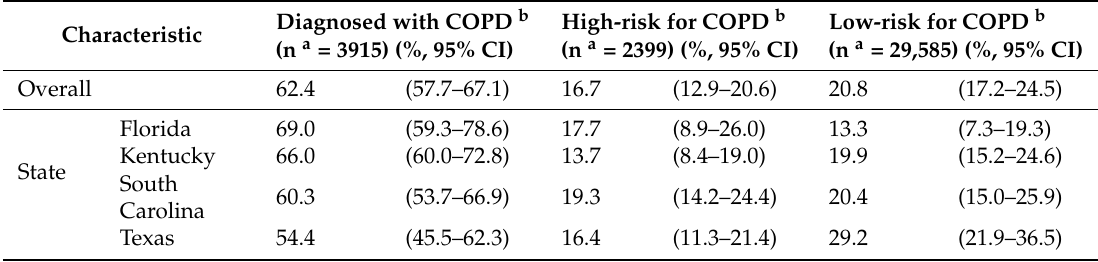
Table 5. State-specific, age-adjusted prevalence of frequent shortness of breath among COPD risk categories among adults ≥ 45 years-old in each of the four states (FL, KY, SC, TX) using the 2015 Behavioral Risk Factor Surveillance system telephone